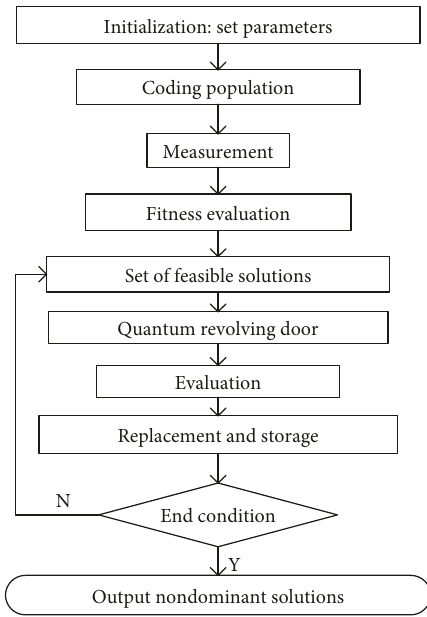
Figure 4: Optimization process of the quantum genetic algorithm.